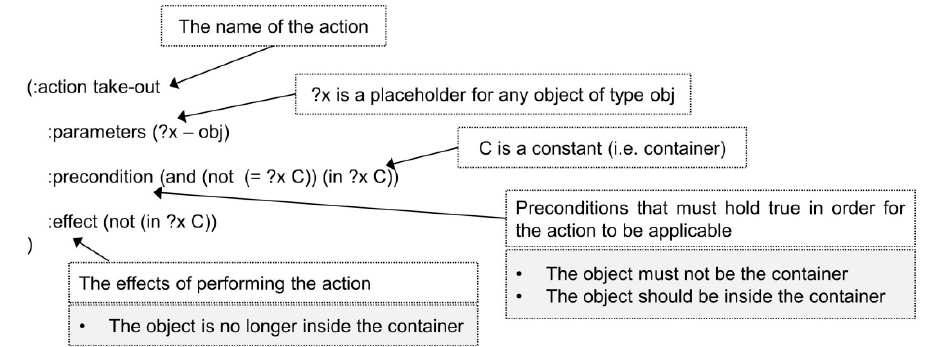
Figure 8. Schema of the action take-out defined in Planning Domain Definition Language (PDDL). The objective of this function is to take an object out of a